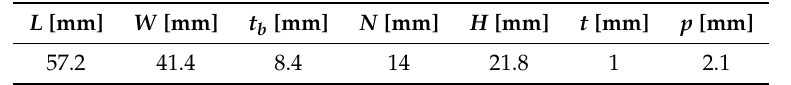
Table 1. Geometrical parameters of the commercially available heat sink experimentally tested.